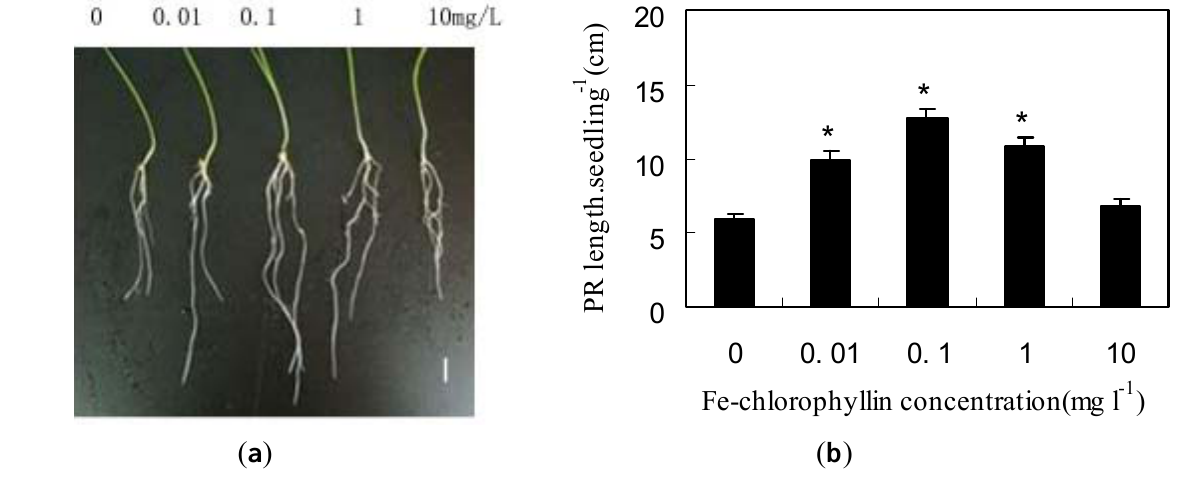
Figure 1. Fe-chlorophyllin regulates the root development of wheat ( a , b ). Seeds of wheat were soaked in distilled water containing various concentrations of Fe-chlorophyllin for 12 h and then transferred to the quarter-strength Hoagland’s nutrient solution containing different concentrations of Fe-chlorophyllin for six days after germination. ( a ) Photograph of wheat primary root formation; ( b ) The length of wheat roots. Values represent the mean of three independent experiments and vertical bars indicate standard deviations ( n = 45 seedlings). Asterisks indicate that mean values are significantly different between the treatment and control ( p <